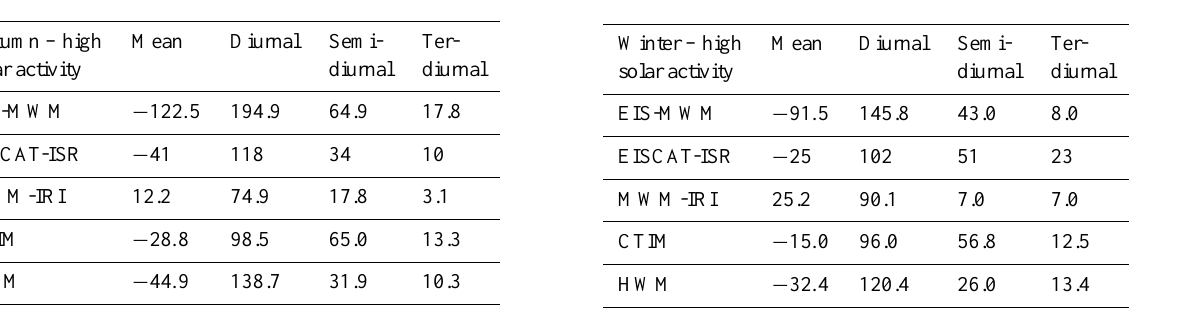
Table 7. As for Table 1 but for autumn season, high solar activity.